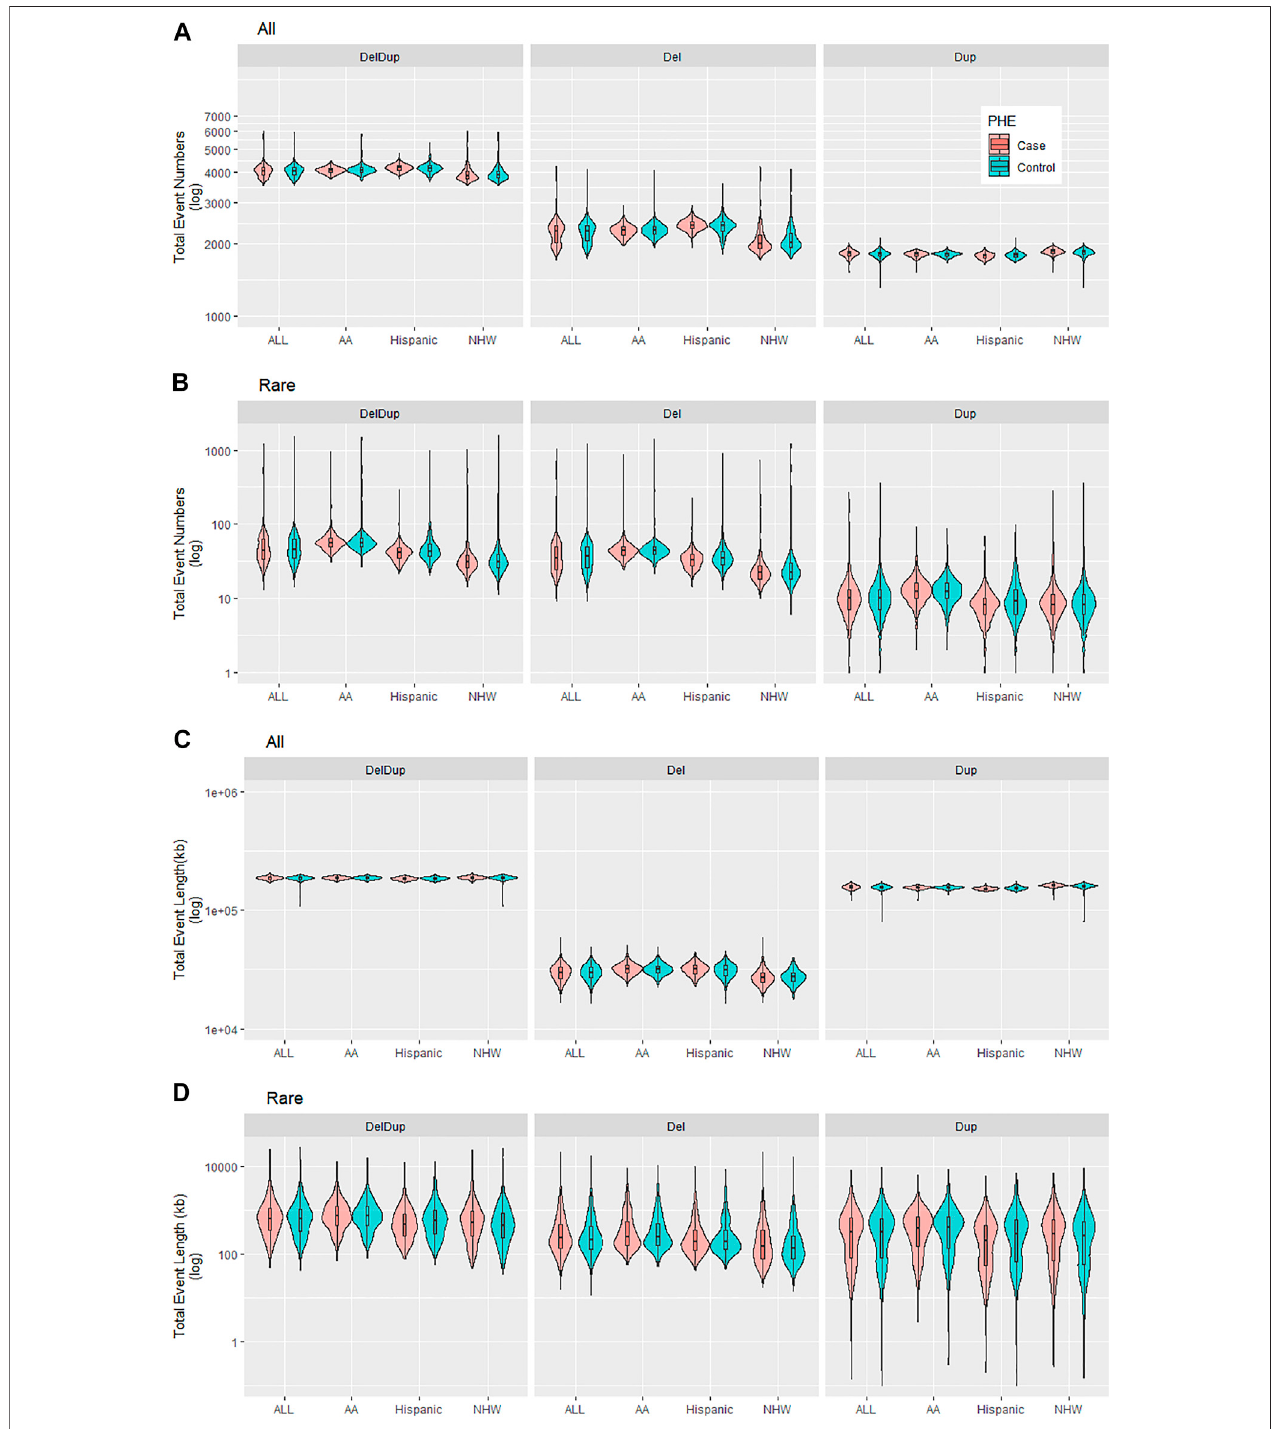
FIGURE4| SummaryofCNVburdenresultsforallandrareCNVsbyCNVevents(DelDup,Del,orDup)andbyethnicities(ALL,AA,Hispanic,NHW). (A). Totalevent numbers per sample. (B). Total rare event numbers per sample. (C). Total event length in kb per sample. (D). Total rare event length in kb per sample.